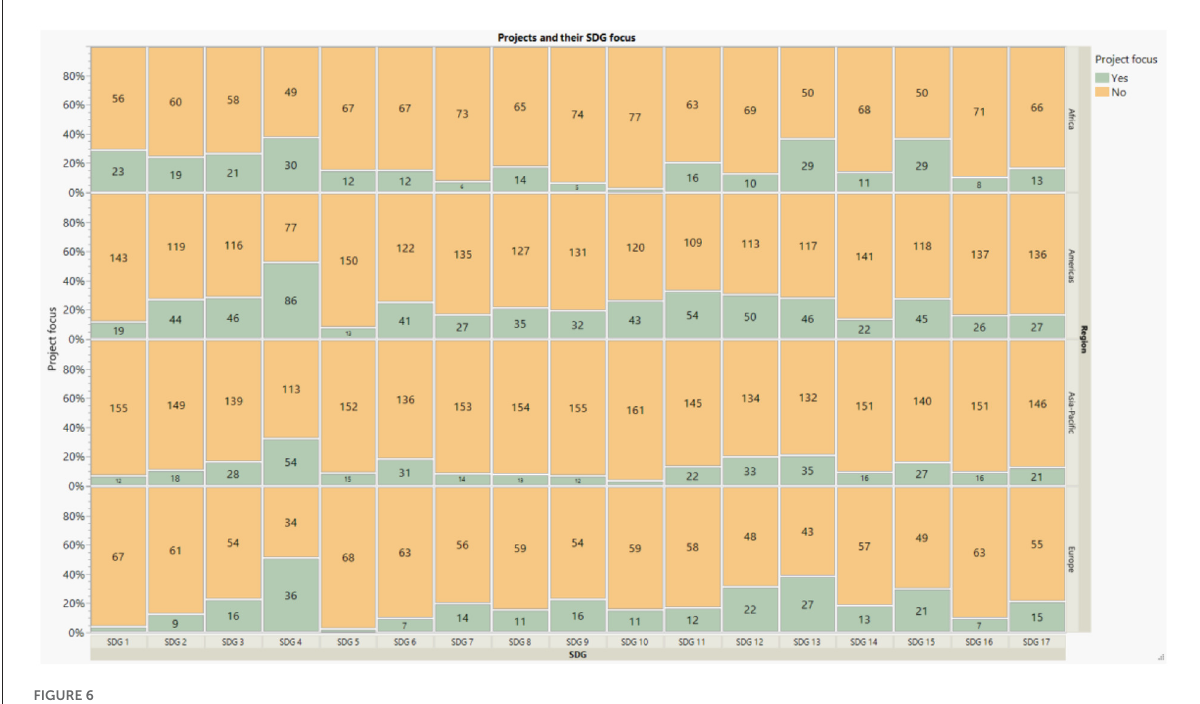
FIGURE6 RCE projects and their SDG focus by